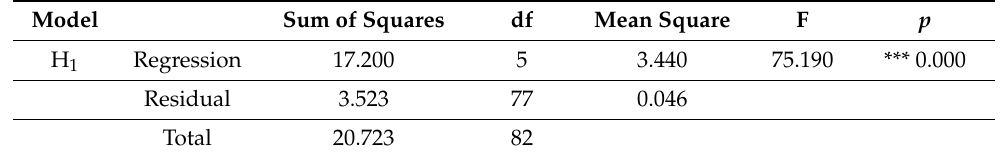
Table 7. Analysis of linear regressions.